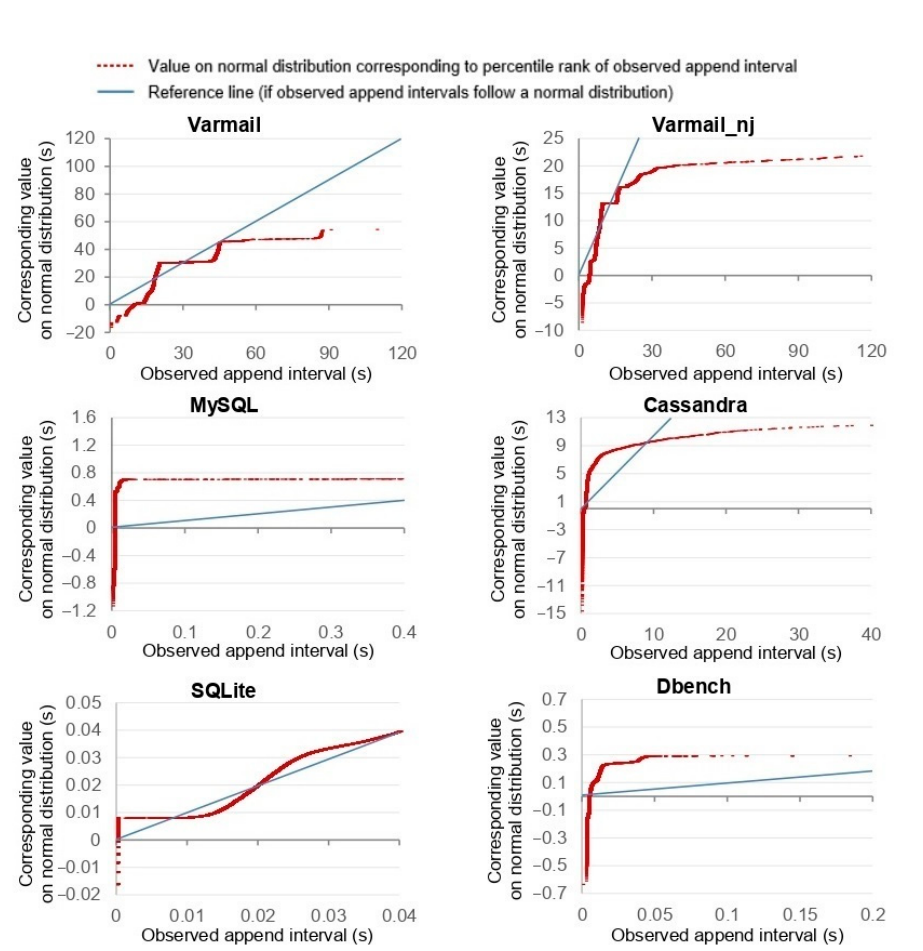
Figure 2. Correlation between observed append intervals and normal distribution.